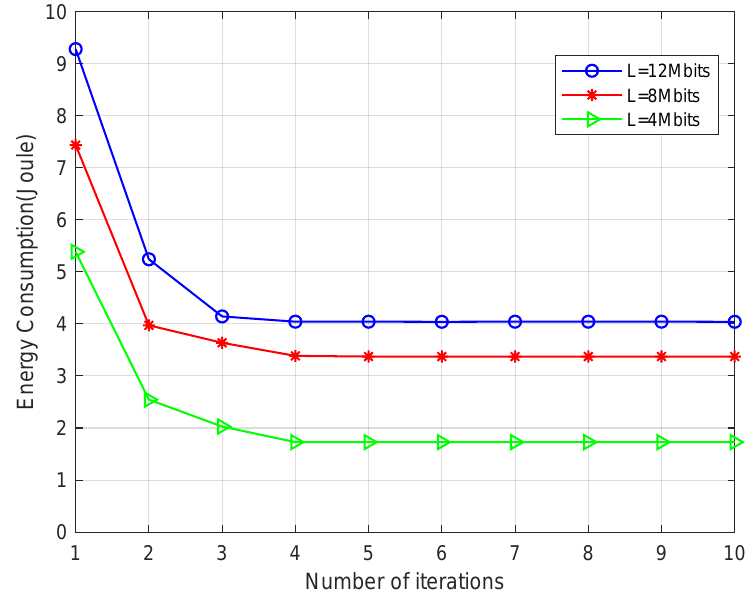
Figure 2. Convergence behavior of the proposed AGIO